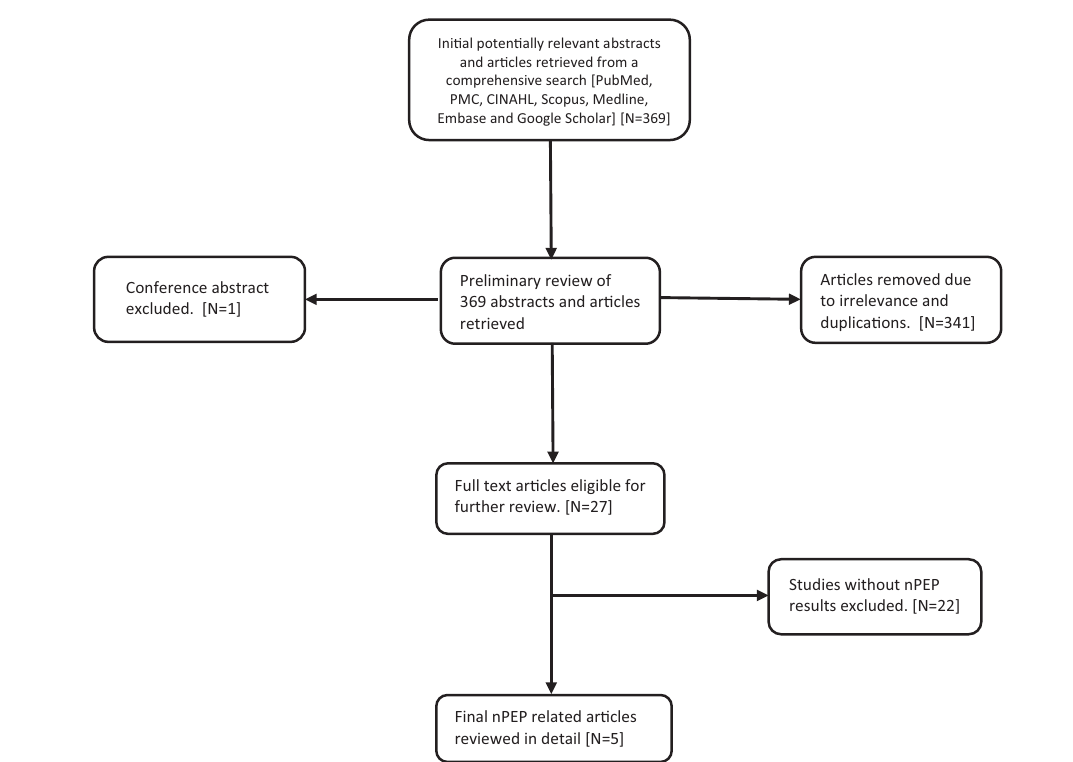
Figure 1: Flowchart of nPEP Research Studies Selection